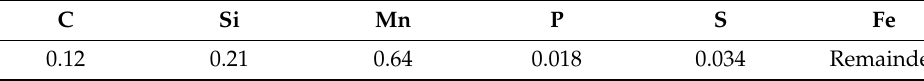
Table 1. Percentage composition of studied sample.